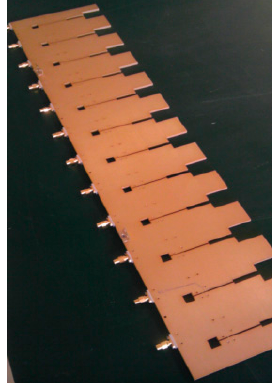
Figure 12. The wideband antenna. Figure 11. The wideband antenna. Figure 11. The wideband antenna. Figure 11. The wideband antenna.